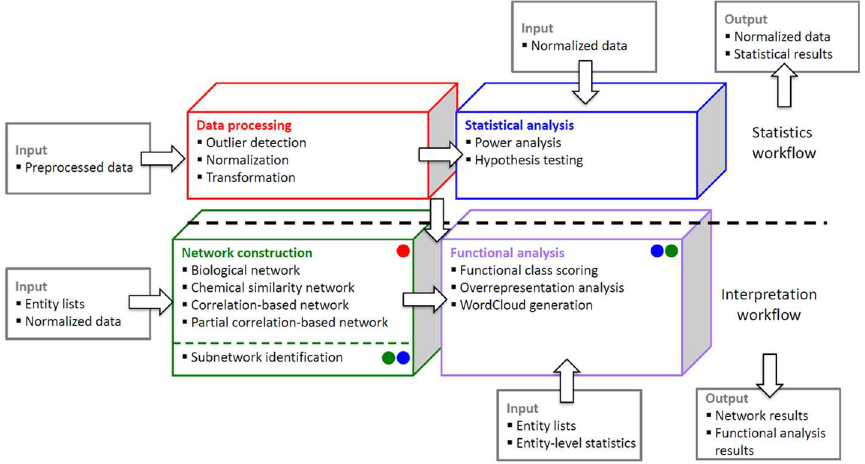
Fig 1. Analysis workflows. Metabox supports in-depthanalysisof metabolomic data by includingfour analysismodules:data normalization(red), statistical analysis(blue), network construction (green) and functionalanalysis(purple).Outputs from each moduleare in red, blue, green and purplecircles respectively. The tool accepts external inputs on each analysislevel. Within metabox, the output from an analysismodule can be used for subsequent analysesin the other modulesdenotedas a coloredcircle inside a